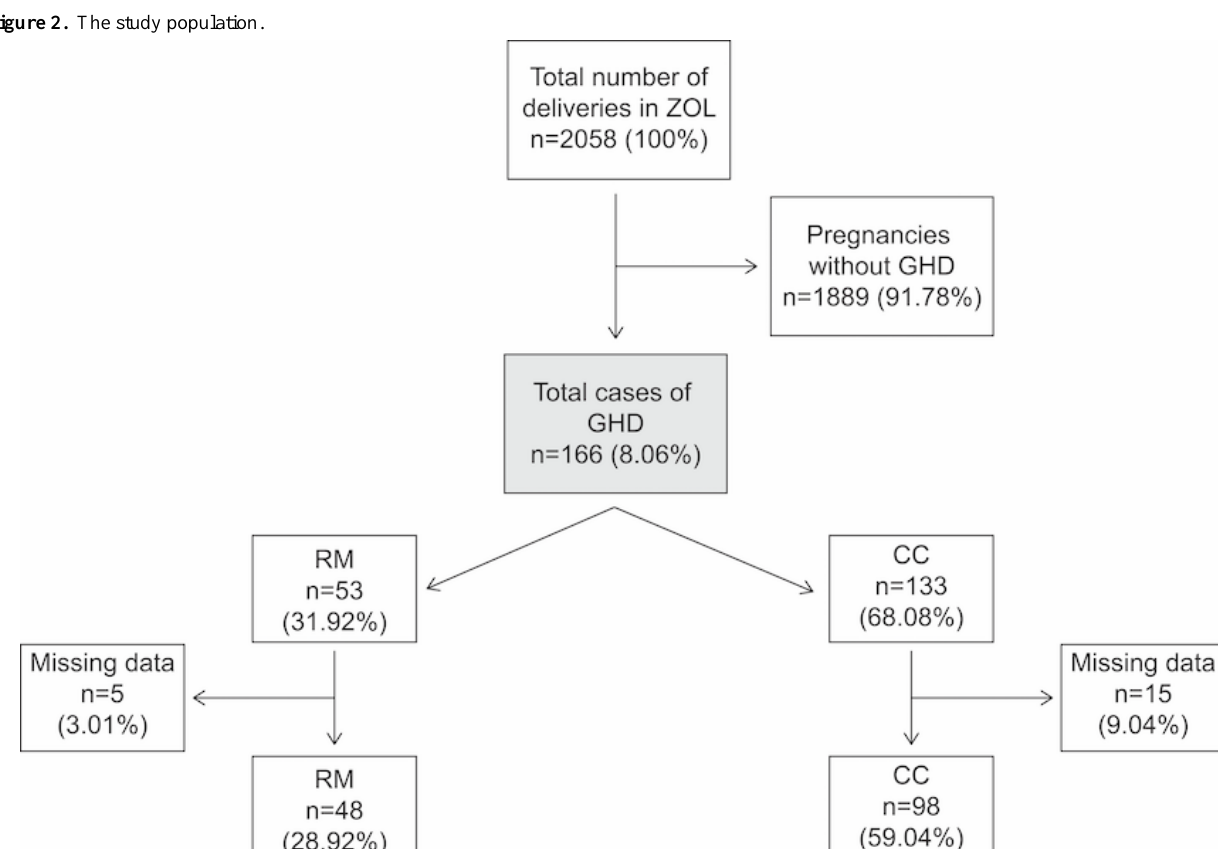
Figure 2. The study